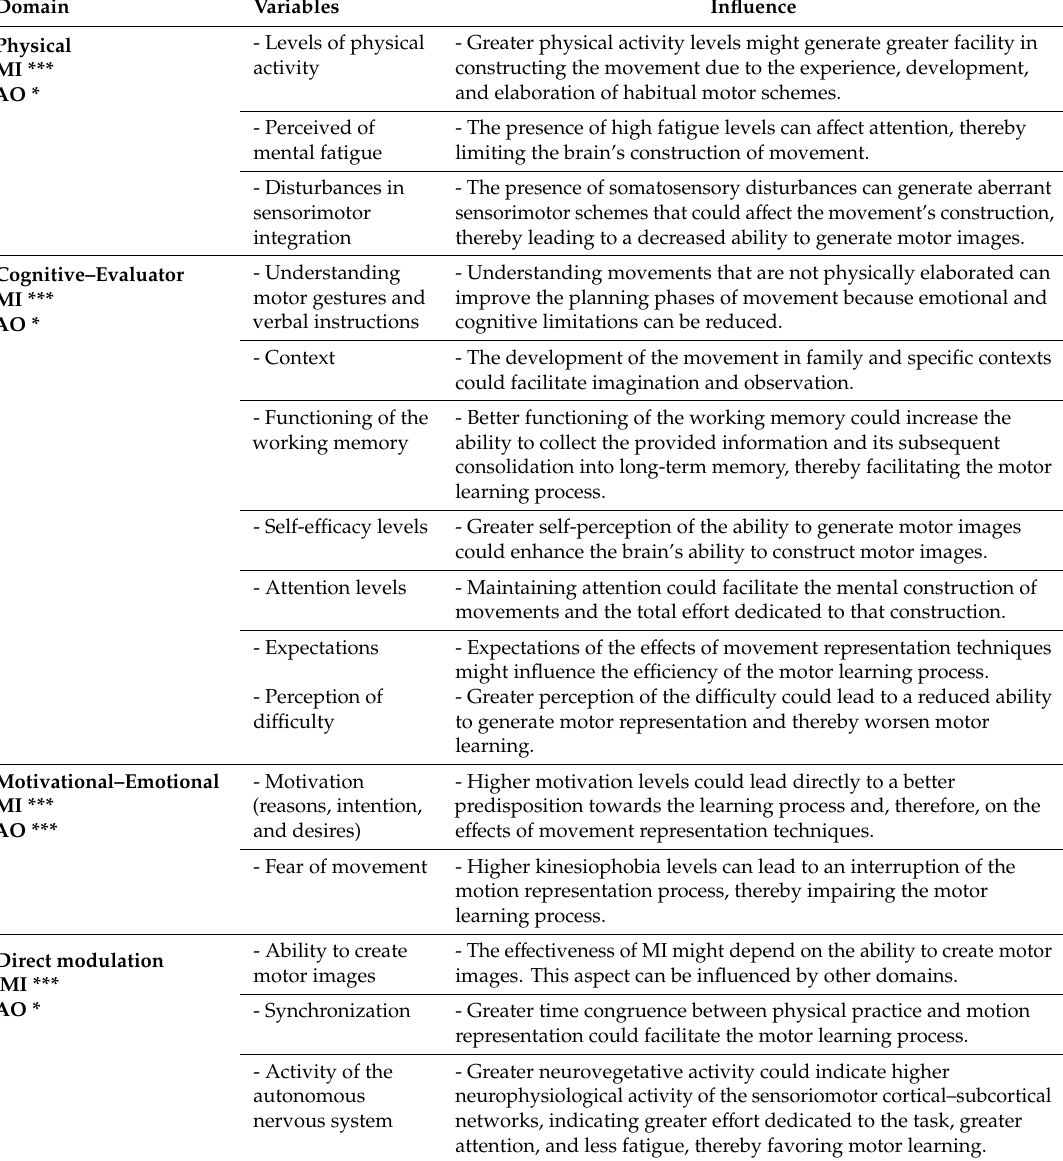
Table 3. Modulating variables of the movement representation